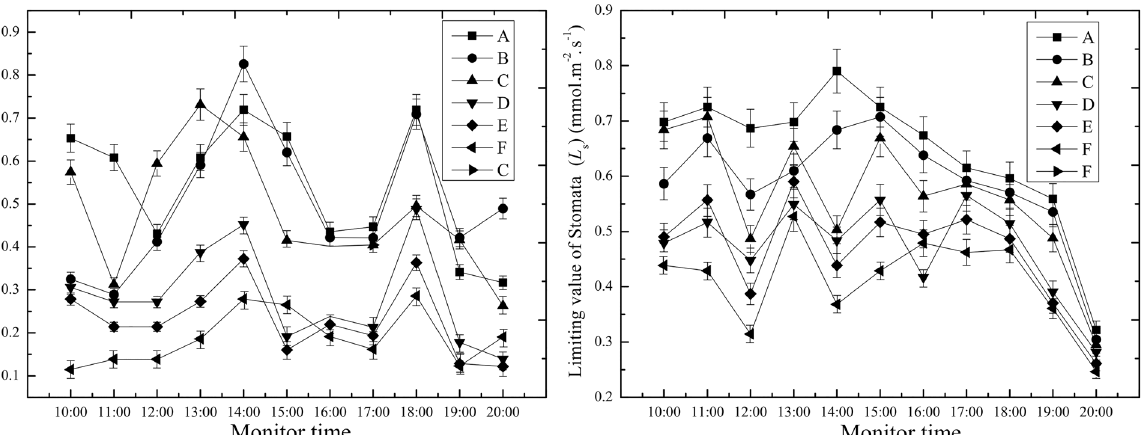
Fig 9. Effect of different salt dust treatments on the stomatal conductance ( G s ) and the limiting value of the stomata ( L s ) of the cotton leaves.